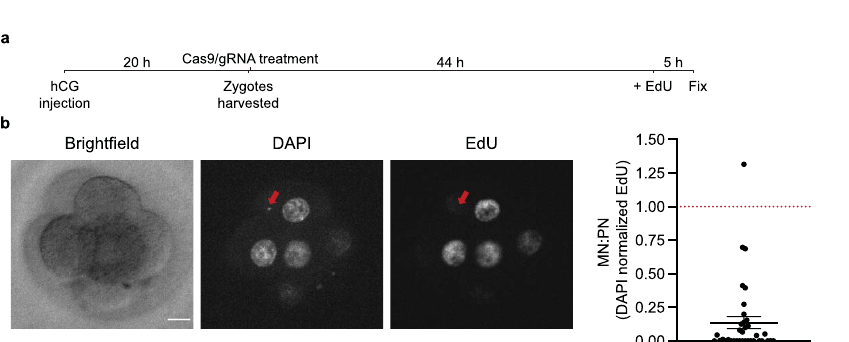
Fig. 3 Micronuclei in embryonic cells undergo defective DNA replication. a Scheme for the experiment. hCG human Chorionic Gonadotropin. b Left, representative single z-focal plane image of blastomeres, quanti fi ed in the right panel, by bright fi eld confocal microscopy and corresponding fl uorescence DAPI and EdU-labeling. The red arrow points to a micronucleus (MN) detected by DAPI staining that fails to incorporate EdU, despite active replication in the primary nucleus (PN). Scale-bar: 10 μ m. Right, quanti fi cation of the ratio of density of EdU signal in micronuclei relative to primary nuclei. If micronuclei replicate normally this ratio will be one (dotted red line). Strongly reduced DNA replication was evident in most micronuclei. Error bars: mean ± SEM ( n = 1 experiment with 36 micronuclei scored). Source data are provided as a Source Data fi